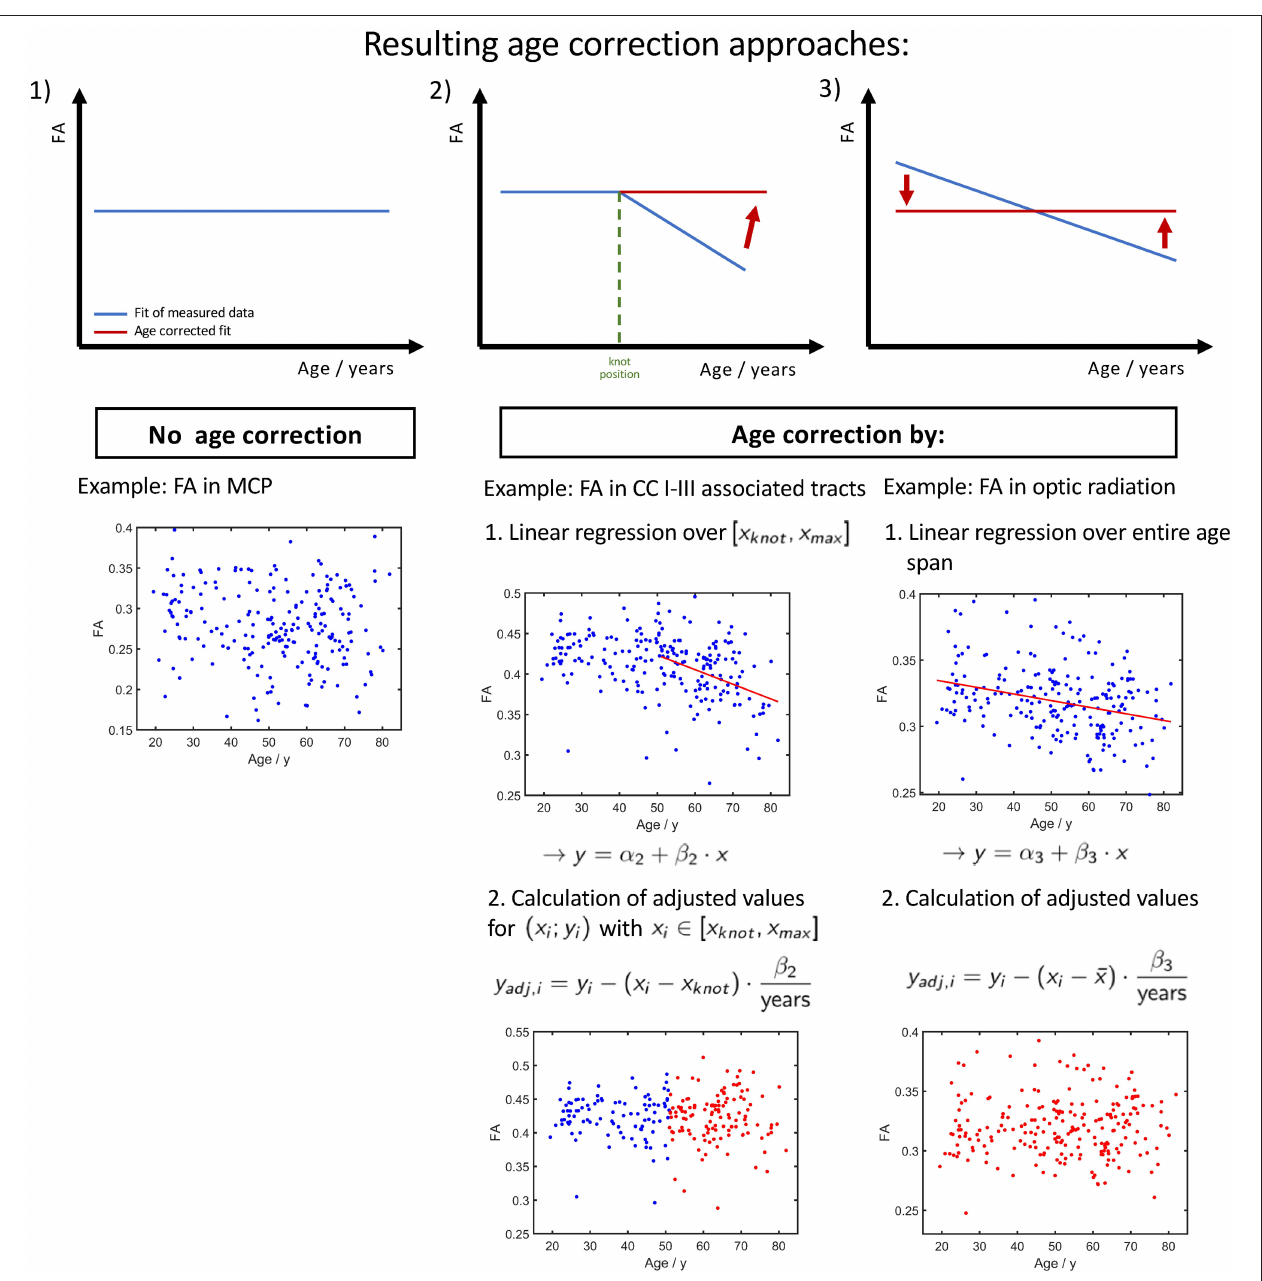
FIGURE 8 | Resulting three different ways of age corrections of FA. (1) Tracts and age ranges where FA remains relatively stable. No correction for age necessary. (2) Age span encloses knot position x knot , i.e., a change of tendency in FA. The age correction is applied only on the time range of FA decrease. (3) Measured FA shows a decrease over the entire investigated age span, and the age correction can be applied to the entire age range.